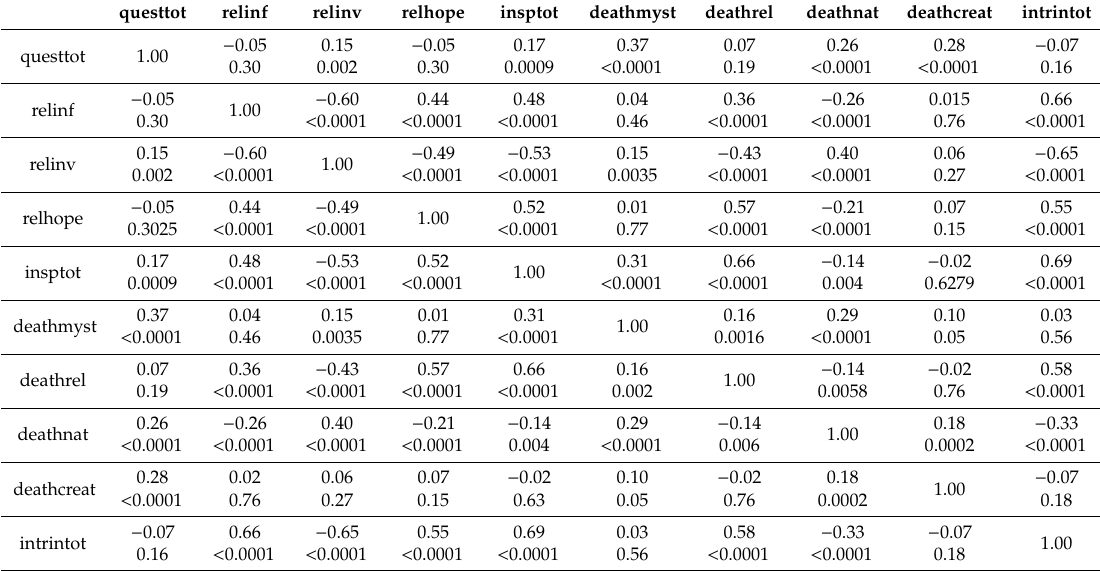
Table 1. Correlations between the various survey questionnaire responses. The correlation is given as the r value with the p -value